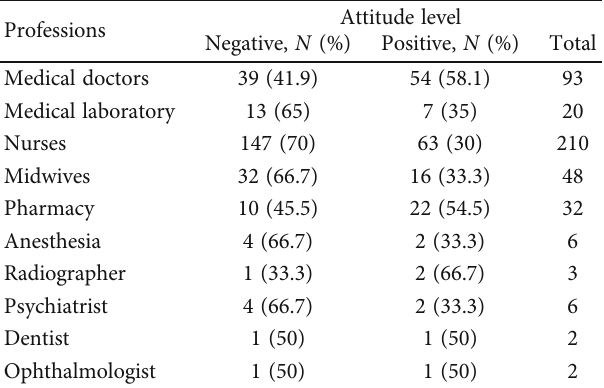
Table 5: Attitude levels of the health professionals about HBV early detection, transmission, and prevention at Tibebe Ghion Specialized Hospital from January 1 to February 30,